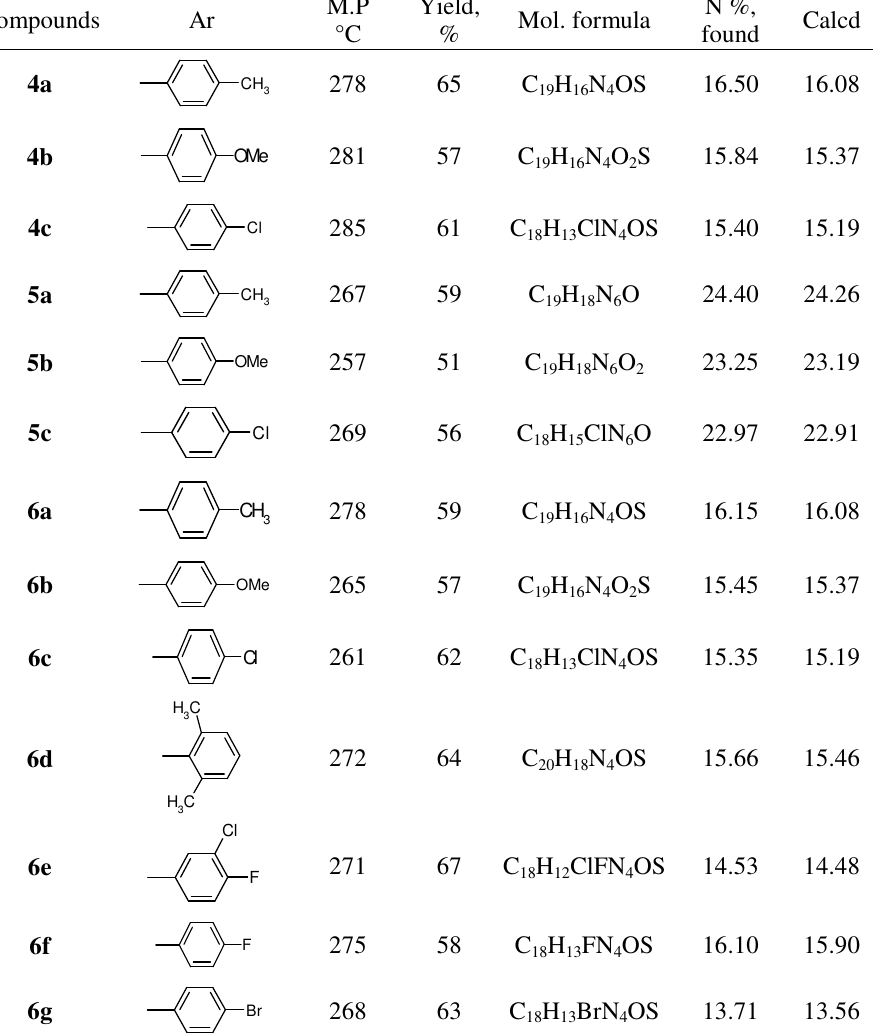
Table 1. Characterization data of the